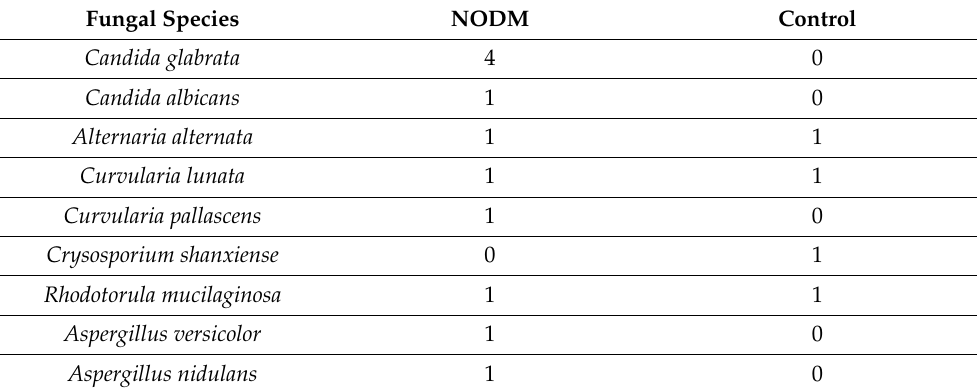
Table 3. Fungal species colonized from fecal cultures in dogs with naturally occurring diabetes mellitus and non-diabetic healthy controls.